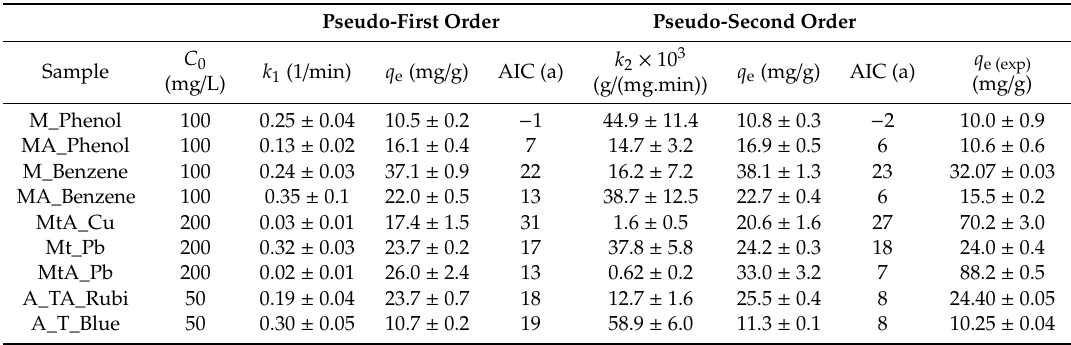
Table 6. Kinetic model parameters for the studied pollutants on the silica-based xerogels and aerogels. Pseudo-First